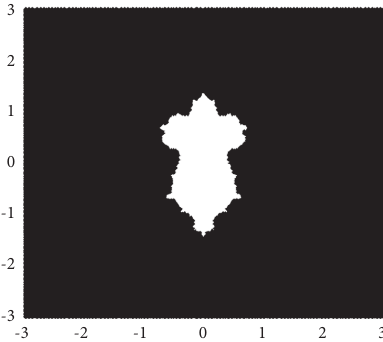
Figure 12: The Julia set of P 0.2i ∈∈ GM ( P